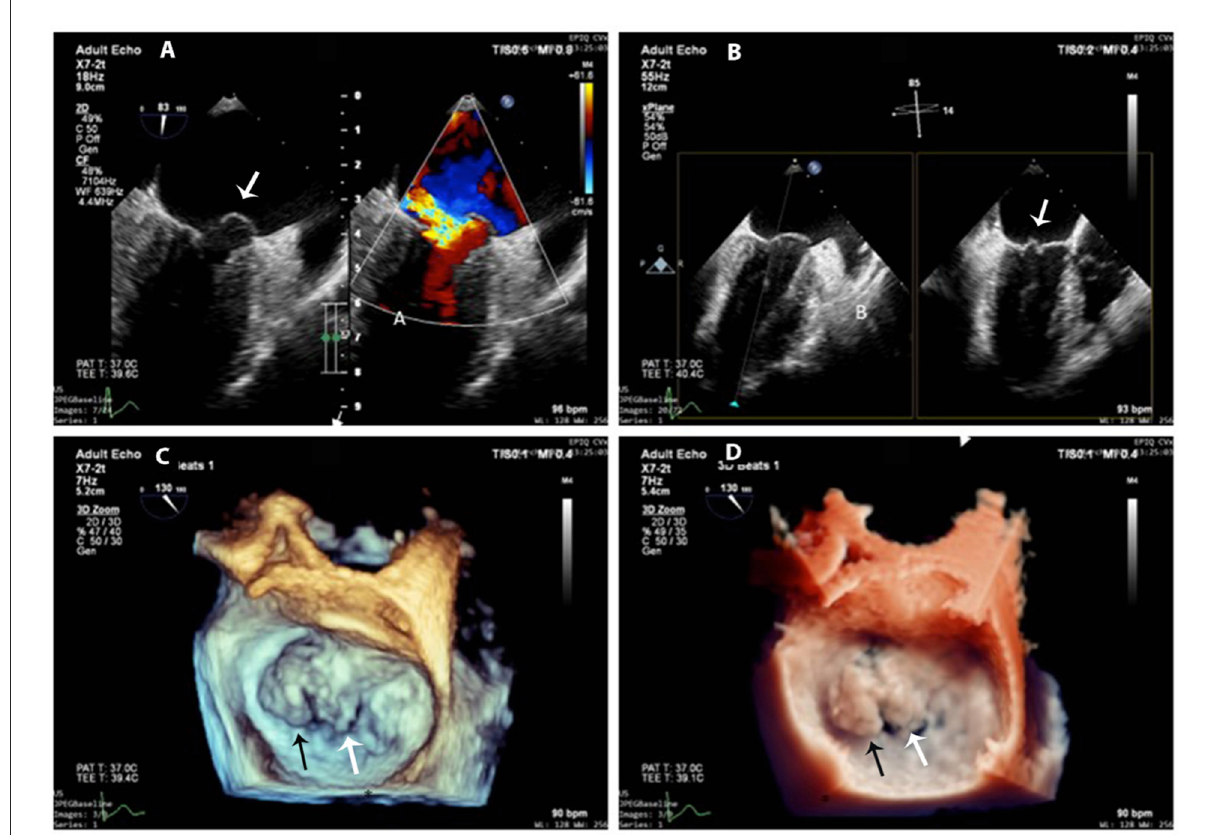
FIGURE4 3D-TEE at 1-year follow-up. (A) Mitral anterior leaflet prolapse (white arrow) on a mid-esophageal two-chamber view (left panel) and the origin of the regurgitation jet with color Doppler (right panel). (B) X-plane imaging with two orthogonal views shows exactly the prolapsed scallops (white arrow). (C,D) 3D-zoom images of the mitral valve from the left atrial perspective (surgeon’s en-face view) show exactly A1 (black arrow) and A2 (white arrow) prolapse (C) normal 3D gain vs. (D) true view mode.